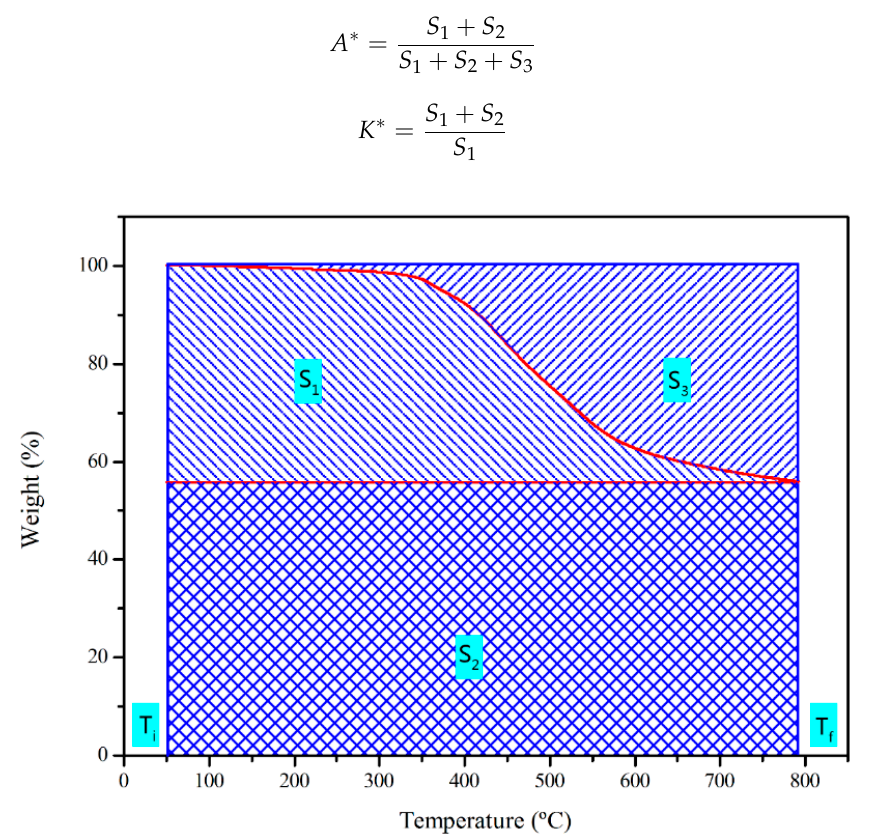
Figure 9. Schematic representation of S1, S2 and S3 for A* and K* .